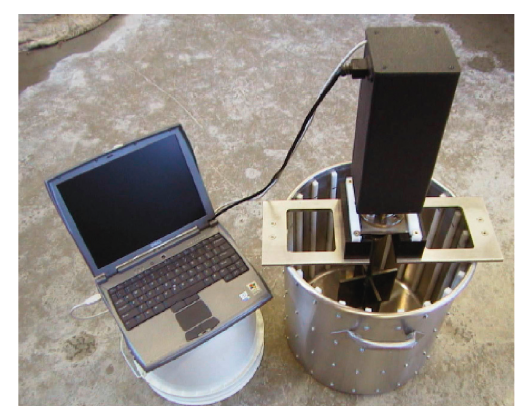
Figure 1: Concrete